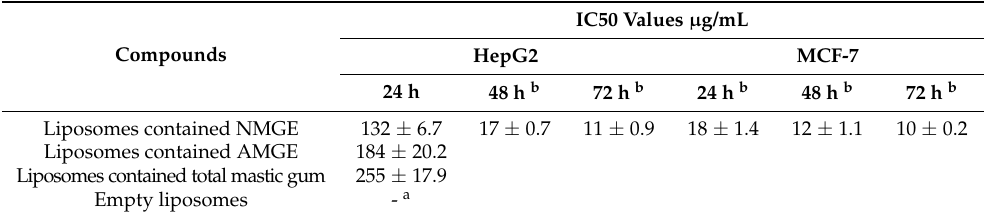
Table 1. Evaluation of the inhibitory activity of the administered extracts against HepG2 and MCF-7 cancer cell growth expressed in IC 50 values as determined based on XTT assay.